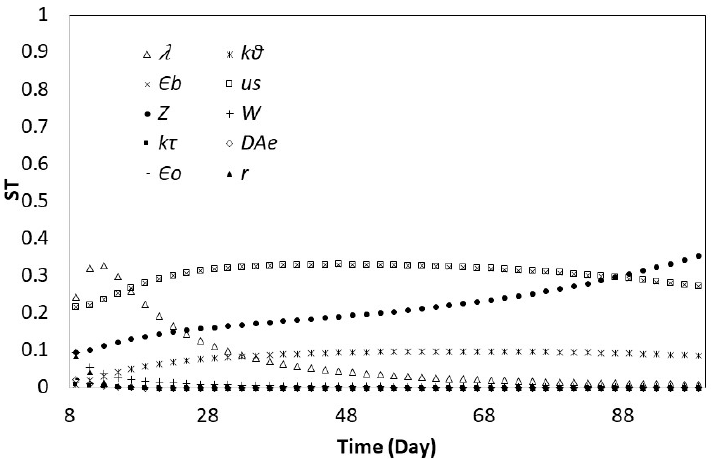
Figure 13. GSA of the model at (cid:2013) (cid:3042) 0.01.